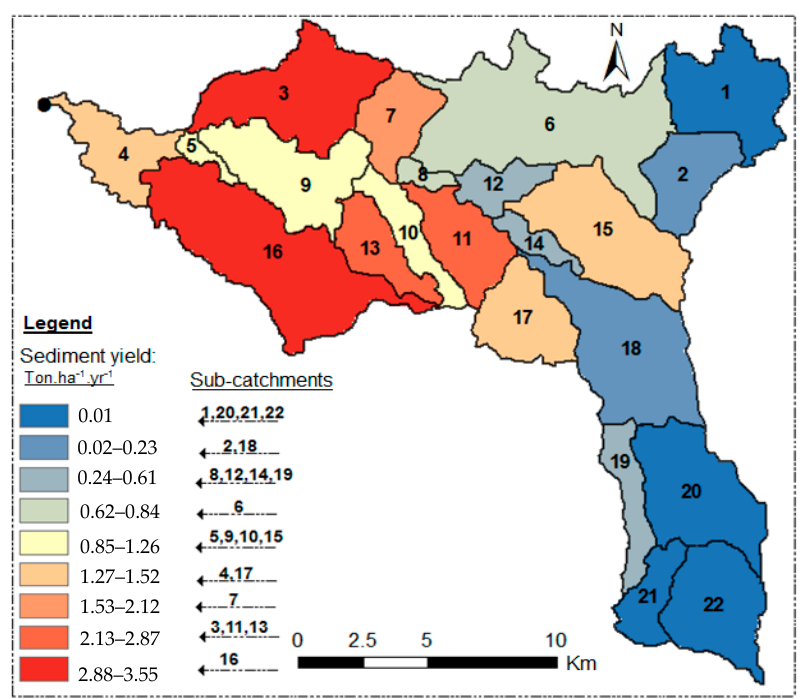
Figure 11. SWAT classified sub-catchments for prioritization (Sub-catchments 1–22) and distribution of SWAT simulated annual sediment yield in t ha − 1 yr − 1 .